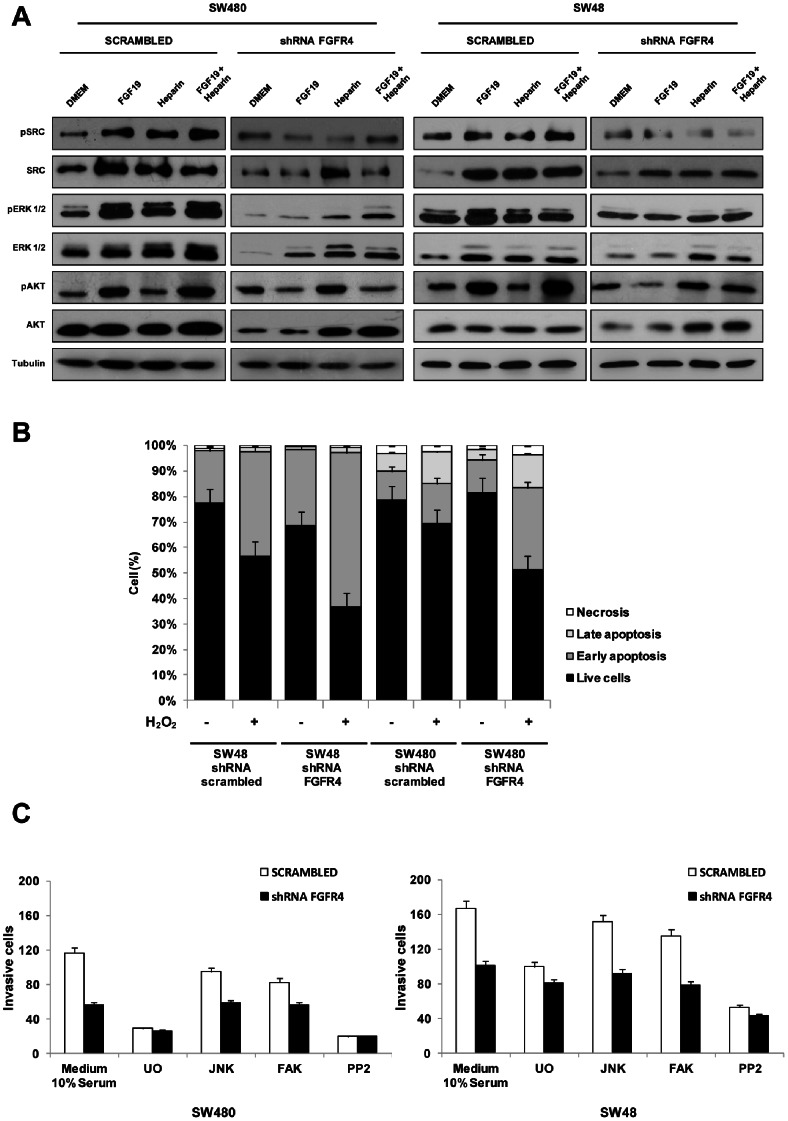
FGFR4 promotes proliferation and cell survival.A. Scrambled and FGFR4-silenced SW480 and SW48 cells were starved, and incubated with FGF19, heparin, or FGF19 plus heparin for 30 min in DMEM. Then, cells were lysed and subjected to WB analysis using specific antibodies against phosphorylated and total AKT, ERK1/2 and SRC. Tubulin was used as loading control. B. Cells were incubated in DMEM supplemented with 10% FBS and antibiotics in presence or absence of H2O2 for 16 hours, and subjected to apoptosis detection assays. Unt., untreated cells. Data showed the results for one representative experiment out of three. C. Invasion across Matrigel of scrambled and silenced cells treated with inhibitors to MEK1/2 (UO126), JNK, and SRC (PP2) as indicated. Data represent the mean ± SD of 3 independent experiments.